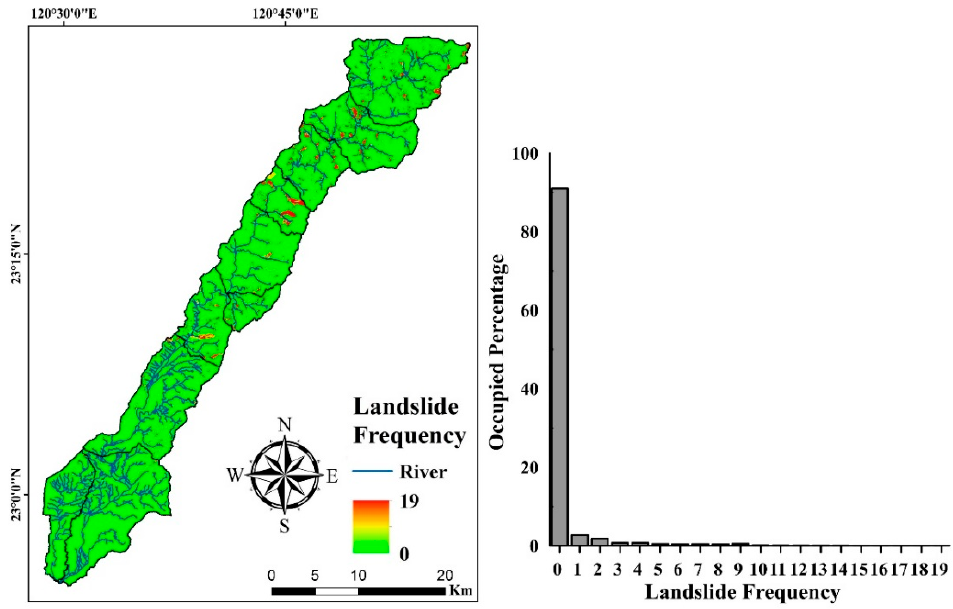
Figure 5. The distribution of landslide frequency from 1999 to 2017 in the Chishan river watershed.